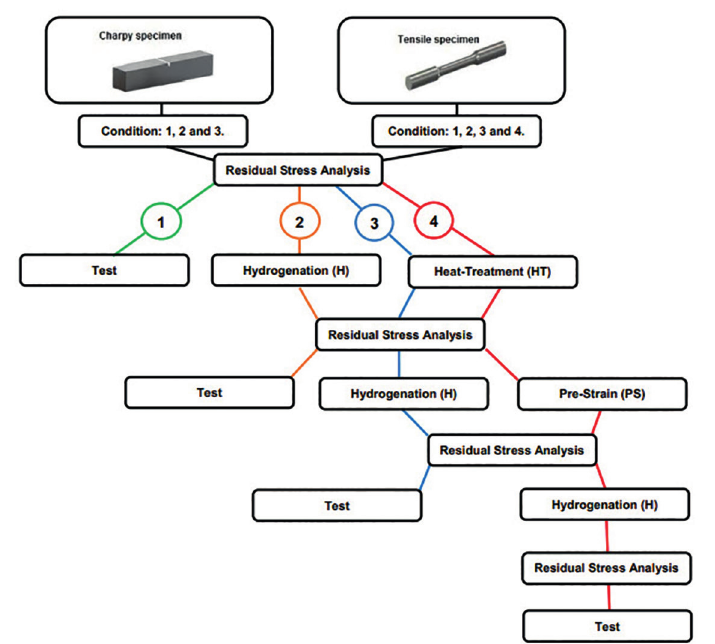
Figure 2: Description of the studied conditions and